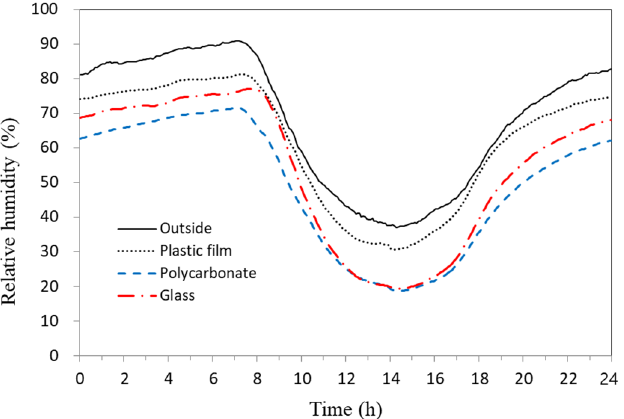
Figure 10. Variations in the outdoor and indoor relative humidity of greenhouses covered with different covering materials (12–13, 19–20, and 26–27 October 2019).